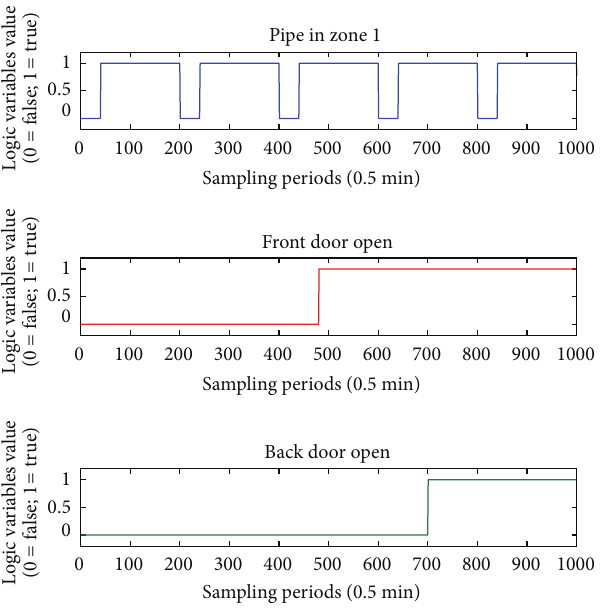
Figure 4: Disturbances during the experiment.